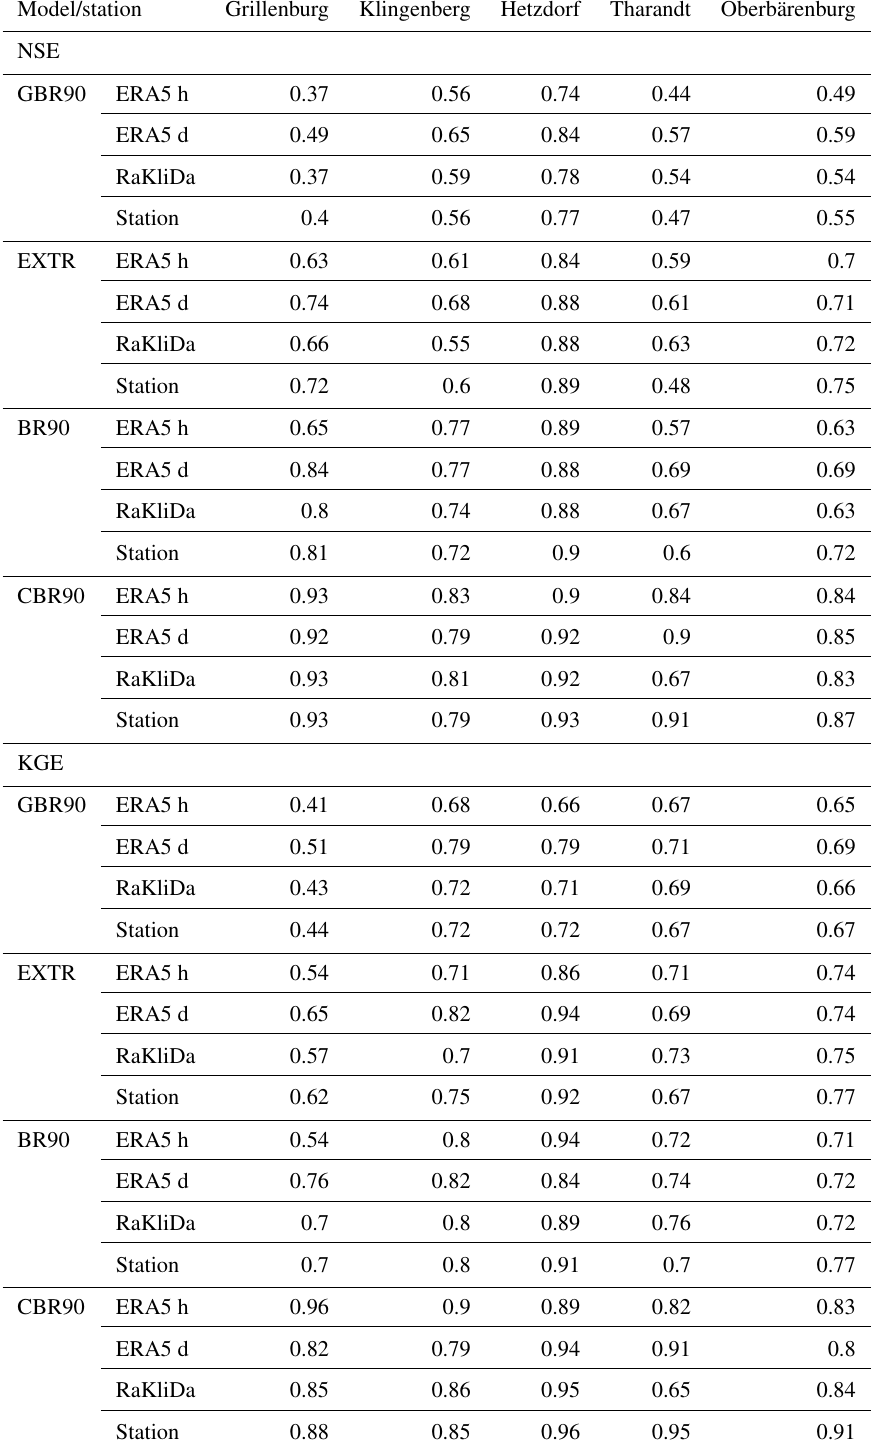
Table E4. Monthly evaporation skill scores for the whole year. Model/station